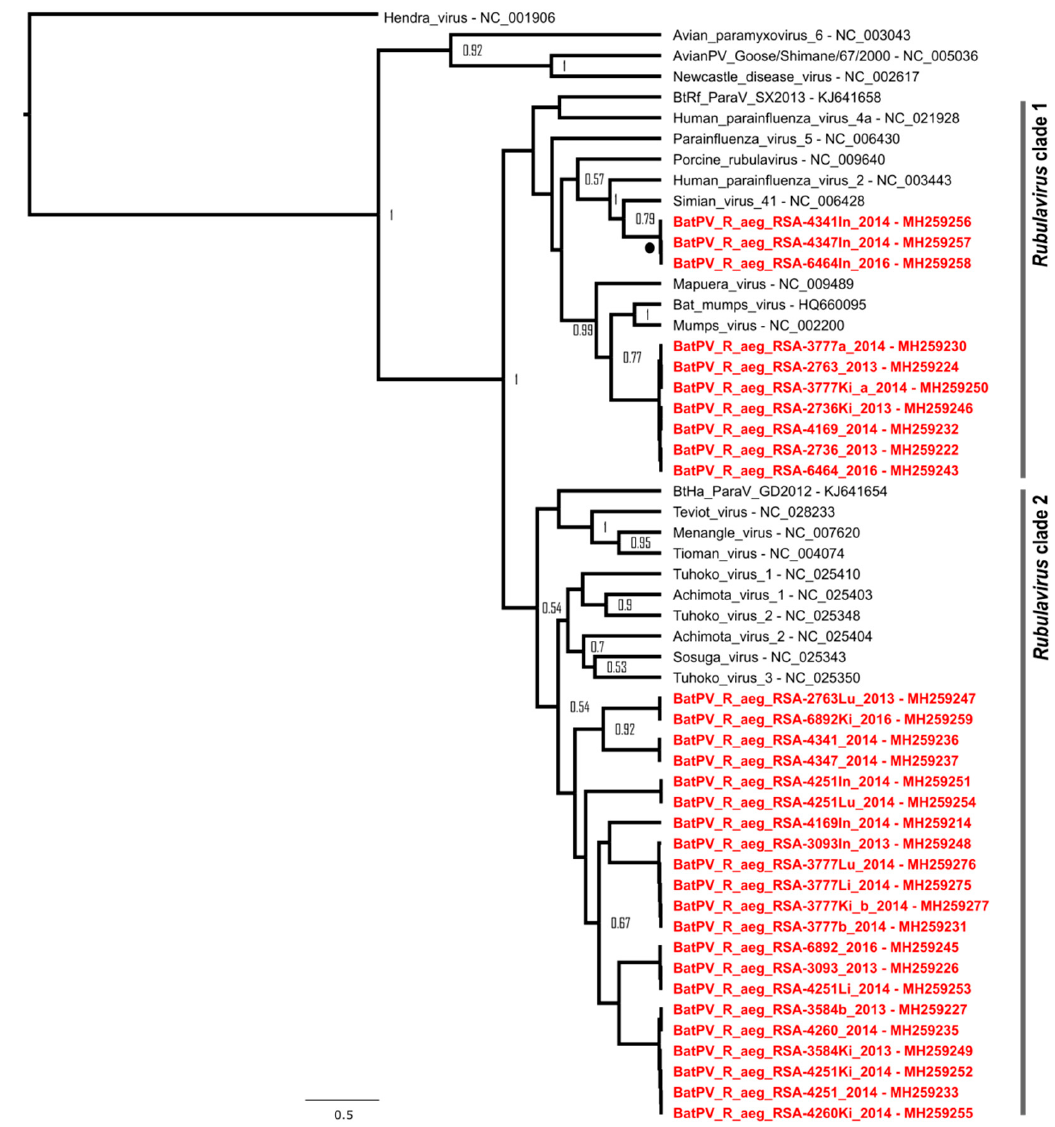
Figure 2. Phylogeny of a partial polymerase ( L ) gene fragment (210 nucleotides) of paramyxoviruses detected in organ tissue using Avula–Rubulavirus genus-specific primers. Bayesian phylogenetic analysis was performed using the TPM3uf model incorporating a gamma distribution (TPM3uf + G). Posterior probabilities of >0.5 are indicated at internal nodes. Sequences indicated in red represent viral sequences detected from organ tissues of individuals that were positive in initial spleen testing. Sequence annotations include abbreviations for additional organs (Ki: kidney, Li: liver, Lu: lung, In: intestines) as well as accession numbers. The black circle indicates an additional sub-clade detected in intestinal tissue not previously detected during spleen and urine testing.